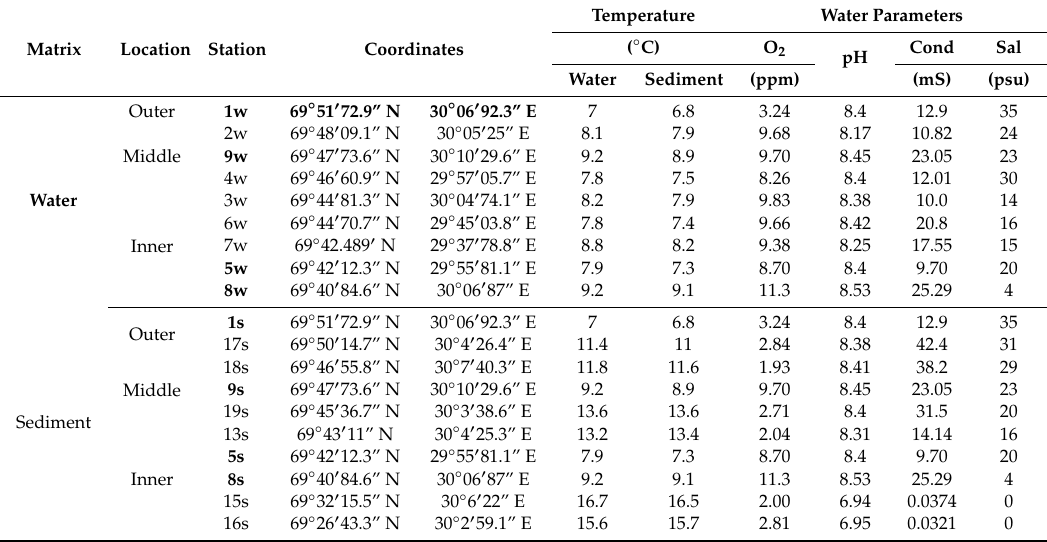
Table 1. Physico-chemical data recorded at each sampling station at sampling time. Stations in bold were sampled for both water and